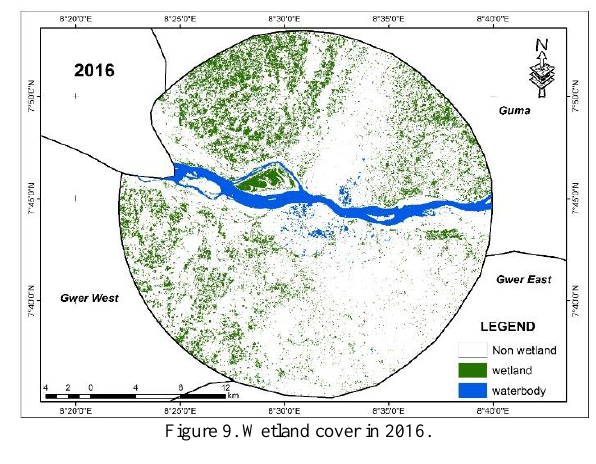
Figure 9. Wetland cover in 2016.